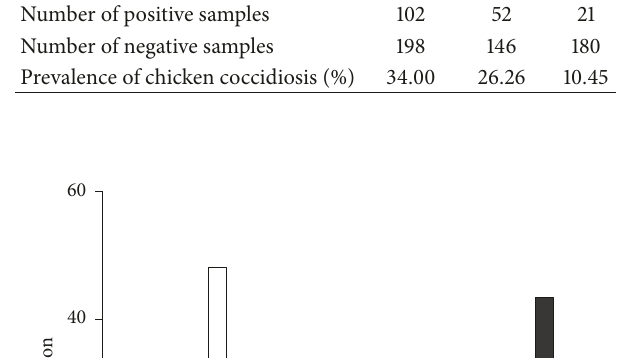
E. acervulina with 8%, E. praecox with 3.1%, E. mitis